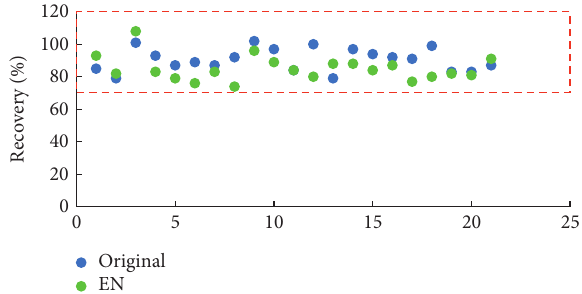
Figure 1: Recoveries ( n � 5) of 21 pesticides from ginseng samples extracted by different QuEChERS methods.